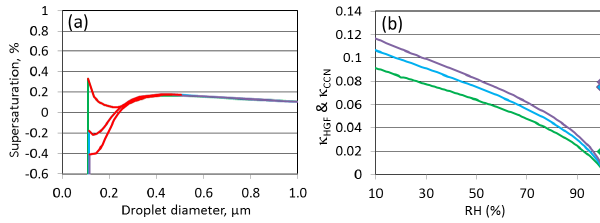
Figure 6. Assuming a surface tension of 40mNm − 1 , Köhler curves (panel a ) and hygroscopicity parameter κ (panel b ) for a particle with a dry diameter of 100nm for SOM-high (green, O:C = 0.472), SOM-low (blue, O:C = 0.513) and SOM-ox (pur- ple, O:C = 0.582). The red segments on the lines in panel (a) indi- cate the presence of LLPS. In panel (b) , κ HGF is given as solid line as a function of RH and κ CCN as diamond at RH =